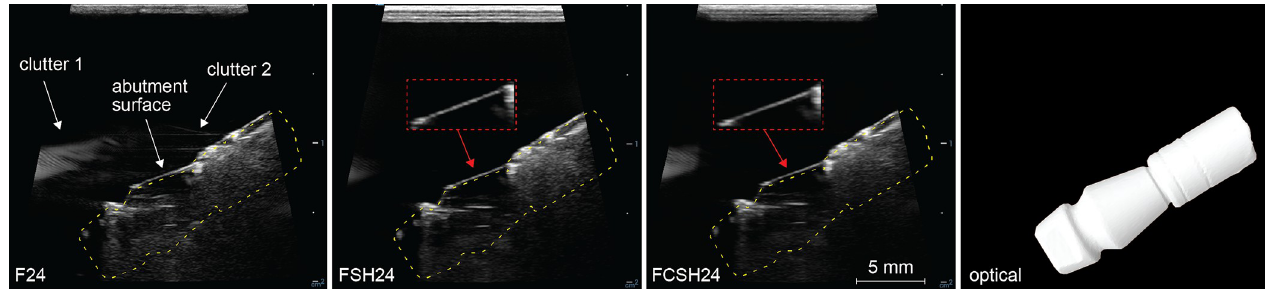
Fig 2. Ultrasonic images of an abutment to illustrate the difference between the investigated imaging modes, namely F24 (single frequency imaging), FSH24 (spatial harmonics), and FCSH24 (compound spatial harmonics). A yellow dashed outline of the abutment is shown within each ultrasound image. An optical scan of the same sample is shown in the right-side panel. Observable image differences include clutter reduction, which is mostly seen in F24 (clutter 1 and 2), much less in FSH24 and FCSH24. FCSH24 and FSH24 differ in the delineation of the abutment surface. This can be seen in the enlarged inset (red dashed frame), where FCSH24 shows a more continuous rendering of the abutment surface. These differences might influence imaging